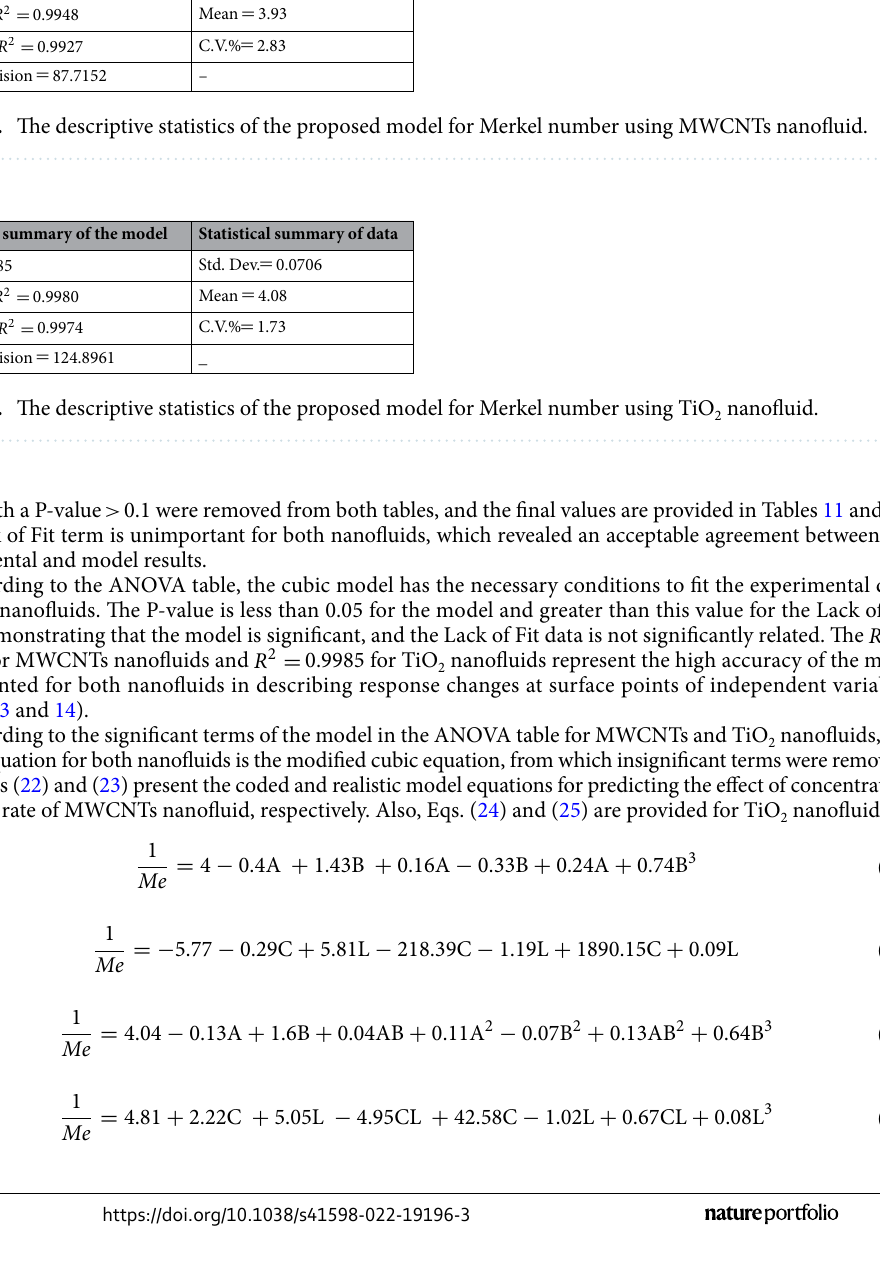
Statistical summary of the model Statistical summary of data R 2 = 0.9959